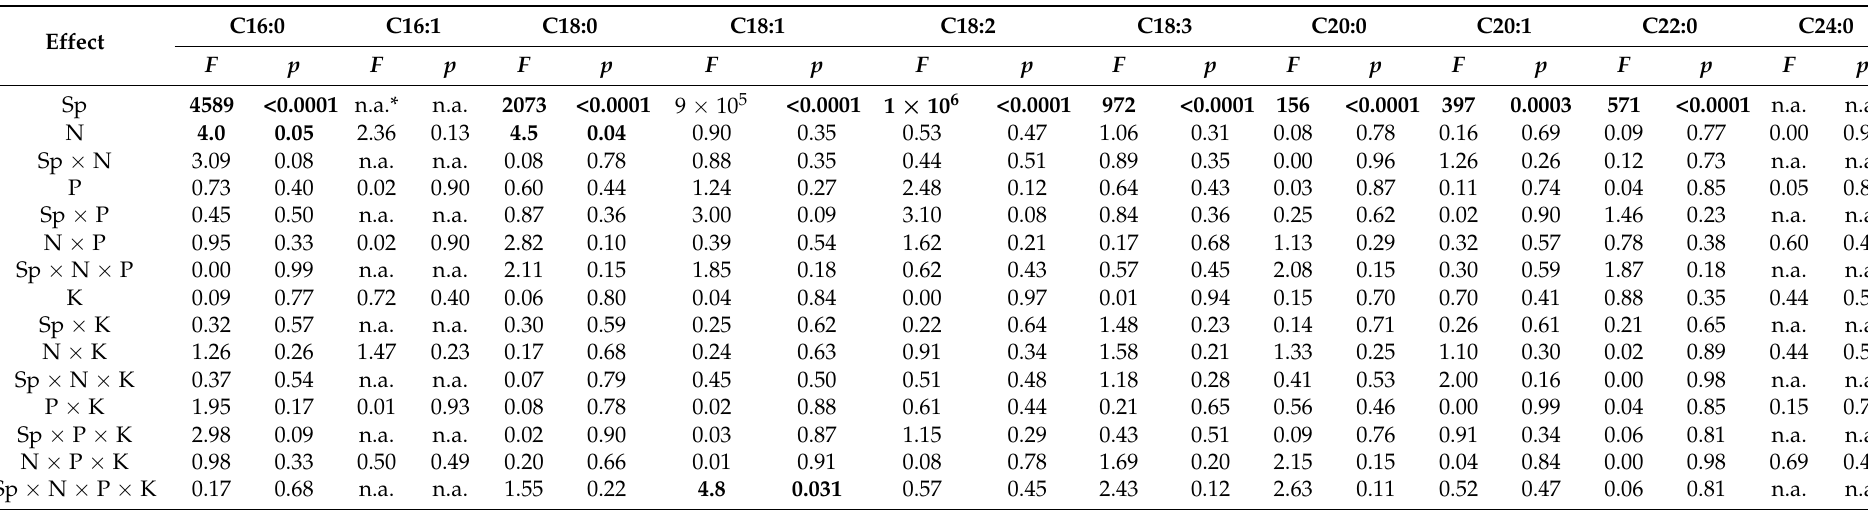
Table 3. F statistics and p-values of the general linear mixed model applied to seed oil composition. Factors were the plant species (Sp) and each of the three main nutrients added as a fertilizer (N, P, K). Plant species were Evening Primrose or Rapeseed and each fertilizer factor had two treatments: either added or not. Fertilizers were nested into Sp. When the p -values were lower than 0.05, F and p are shown in bold. * n.a. is for not